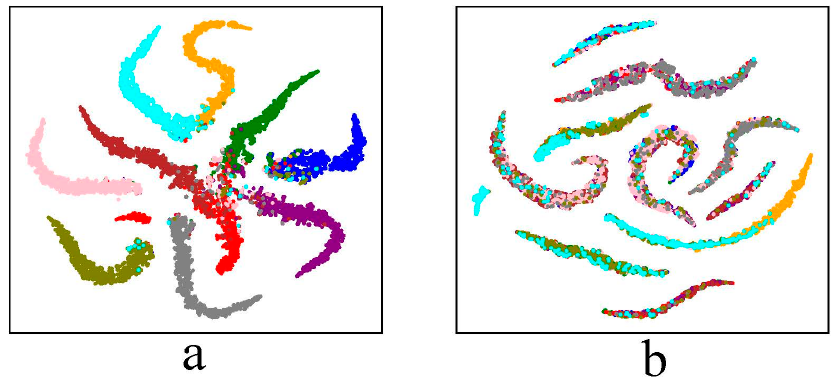
Figure 1. t-SNE visualization of the feature distribution of clean examples and adversarial examples of a standard-trained 11-layer CNN. Examples of the same color have the same ground-truth label. ( a ) Clean examples. ( b ) Adversarial examples.